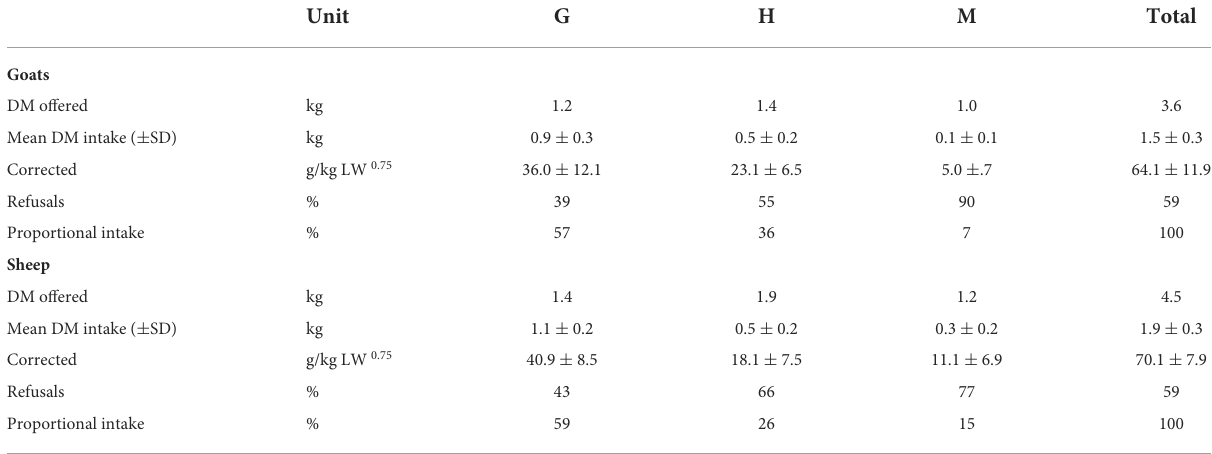
TABLE 2 Observed dry matter (DM) quantities of grass silage (G), hay (H), and the mixed ration (M) offered and consumed per day and animal. Unit G H